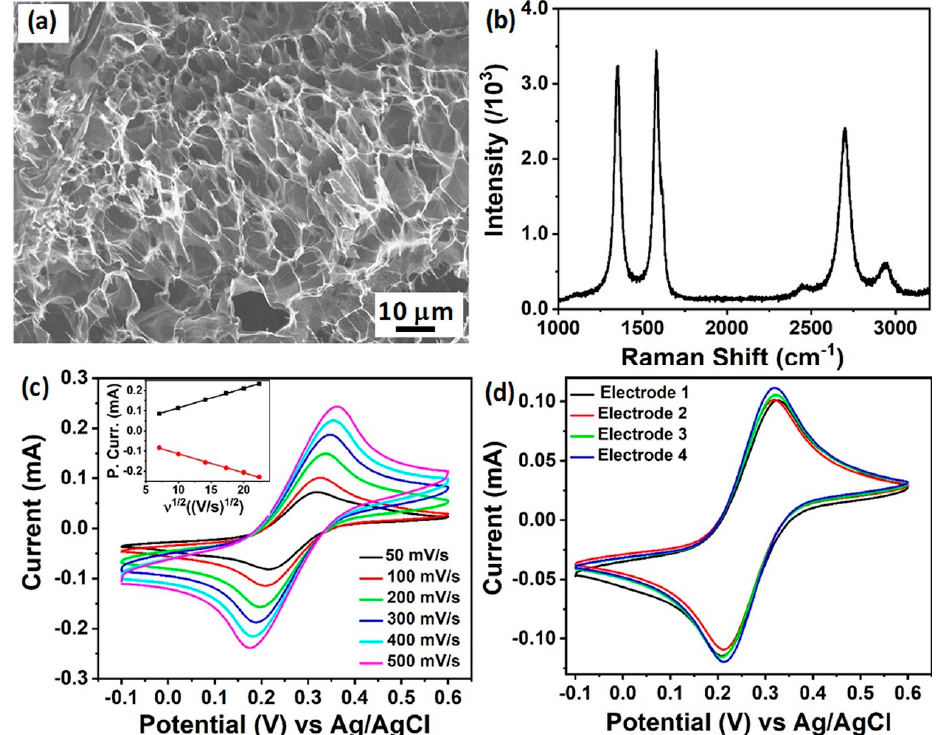
Figure 1. ( a ) Scanning electron microscope (SEM) image of a typical graphitic carbon electrode; ( b ) Raman spectrum of graphitic carbon electrodes; ( c ) cyclic voltammograms of graphitic carbon electrodes of 5 mM [Fe(CN) 6 ] 3 − /4 − in 1 M KCl; Inset: peak oxidation and reduction current values vs. square root of potential scan rate; ( d ) cyclic voltammograms of graphitic carbon electrodes of 5 mM [Fe(CN) 6 ] 3 − /4 − in 1 M KCl for four different electrodes.